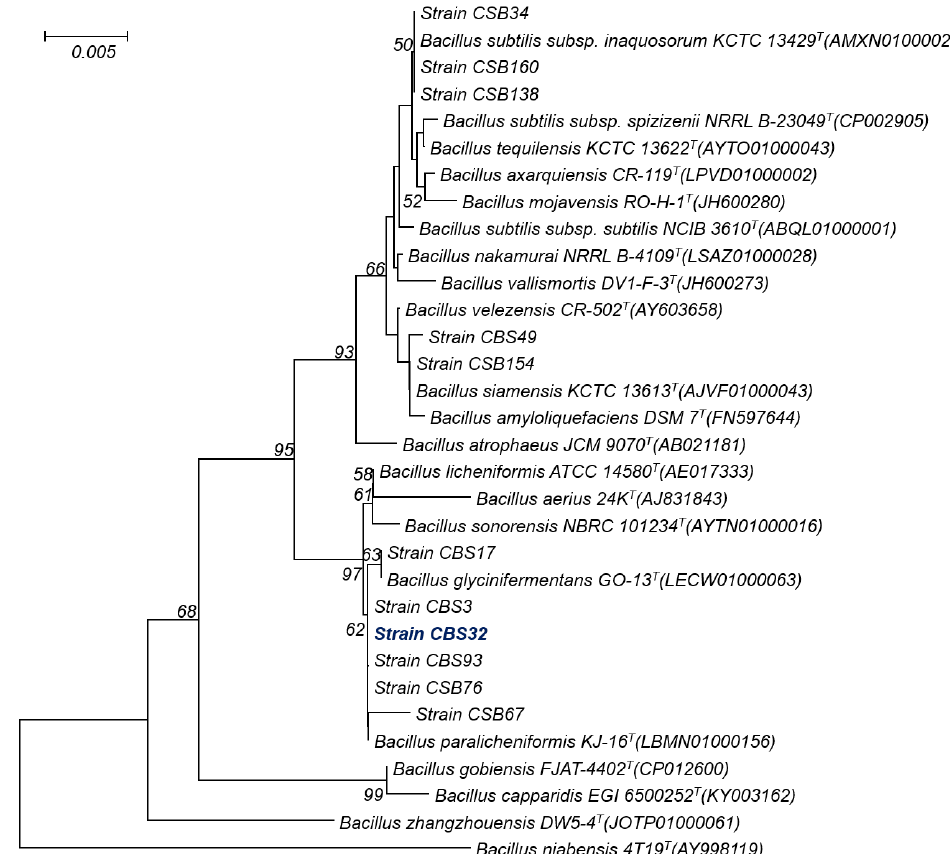
Figure 1. Neighbor-joining based phylogenetic on nearly complete 16S rRNA gene sequences showing relationships among CBS32 and closely related taxa of the genus Bacillus .